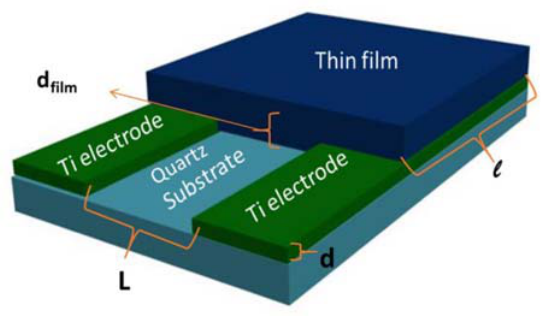
Figure 1. The scheme of the bottom parallel electrodes for trans- portation measurement